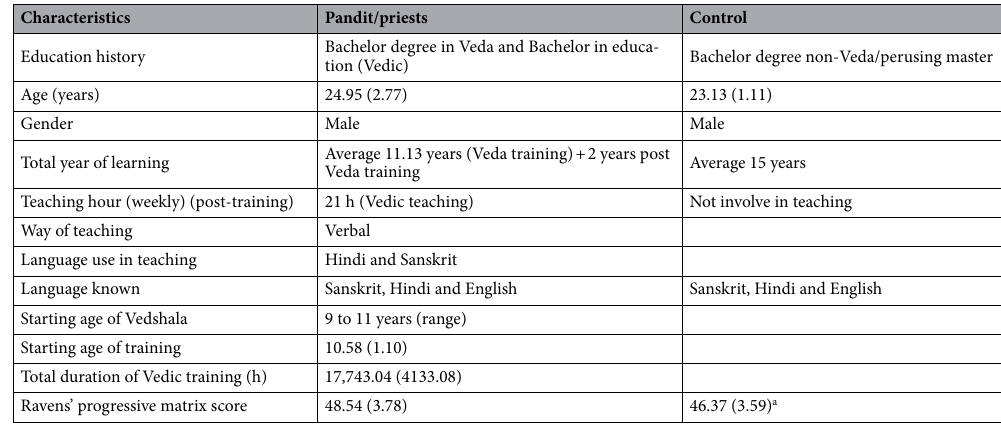
Table 1. Sample characteristics. a No significant differences exist.